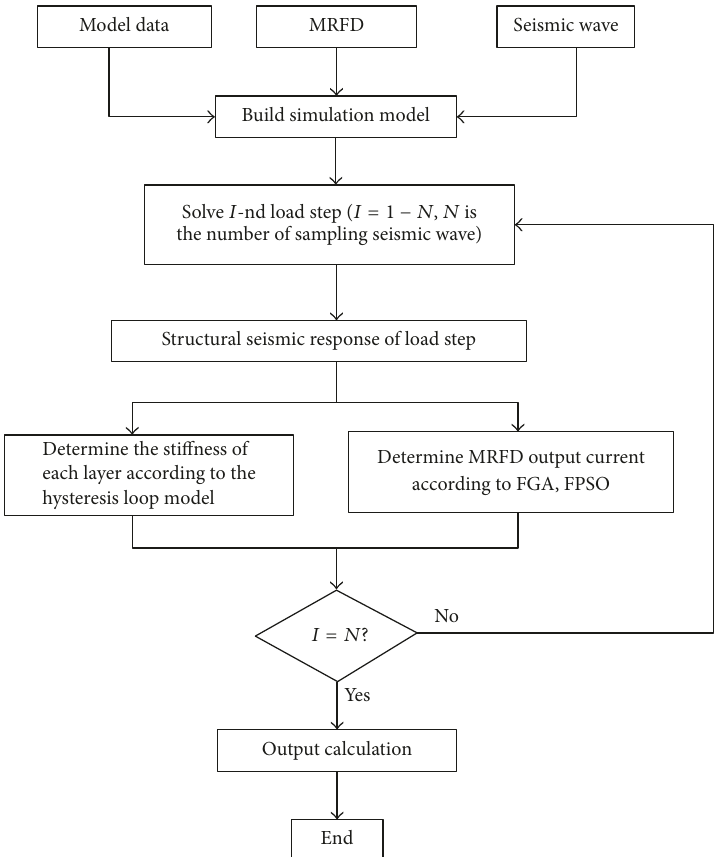
Figure 13: Flow chart of structure simulation program under seismic action.